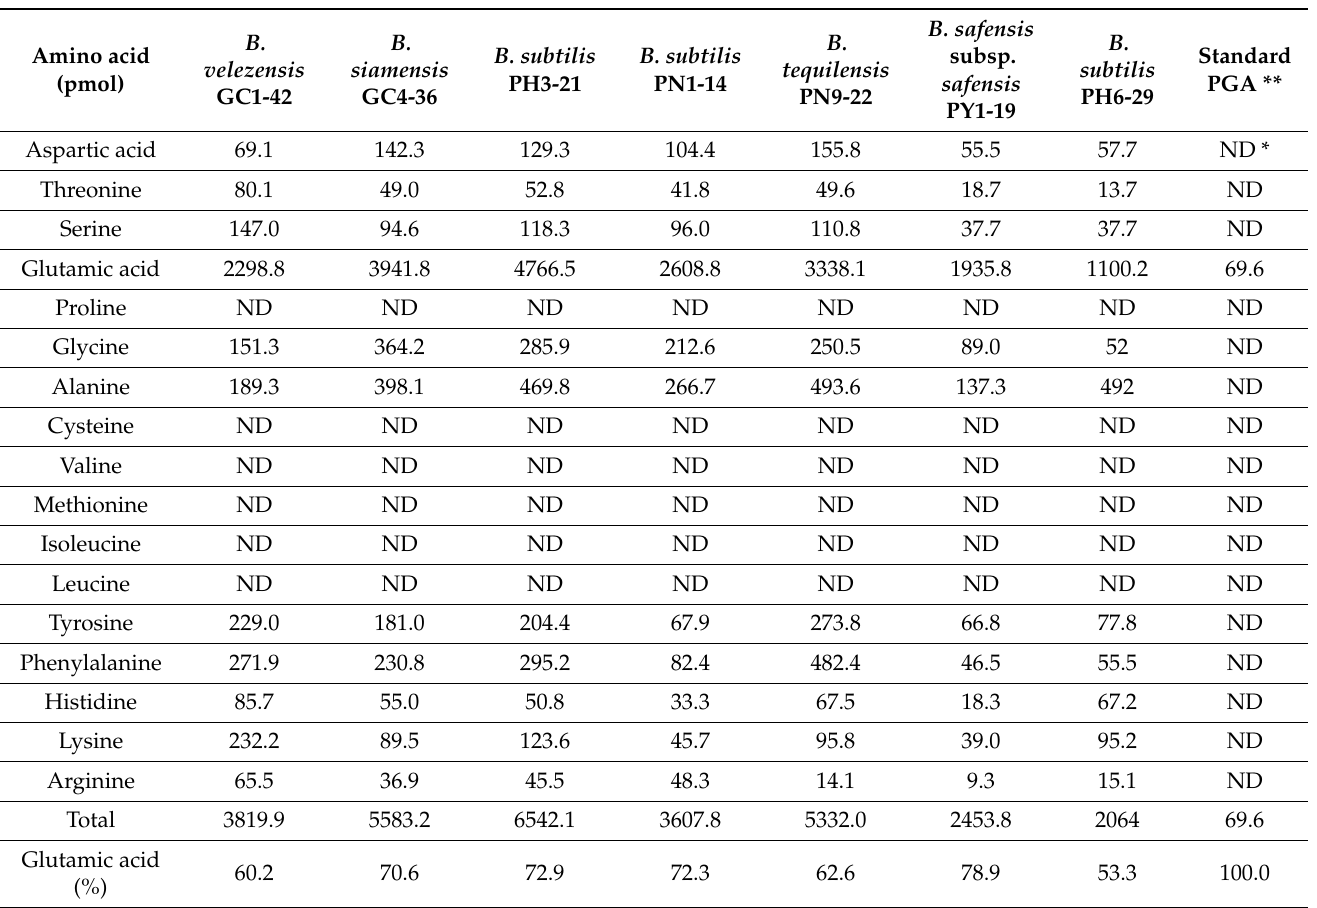
Table 2. Amino acid contents of PGA extracted from Bacillus spp. of naturally fermented soybean